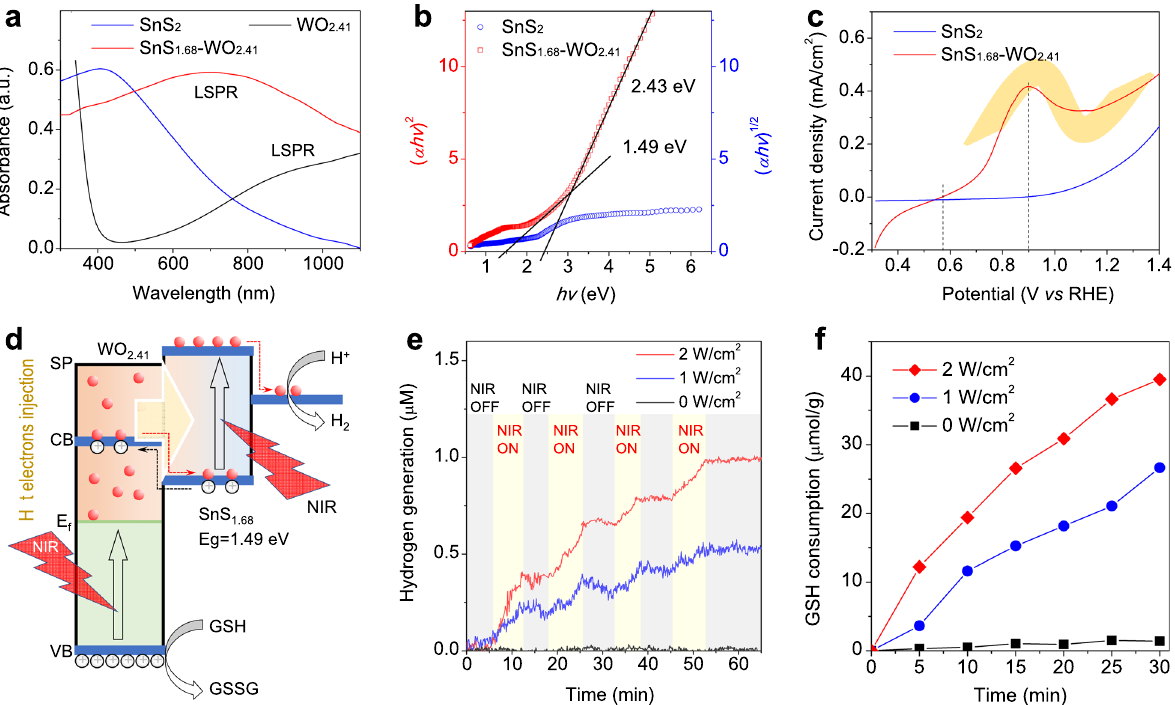
Fig. 3 Photoelectric features and NIR-photocatalytic hydrogen generation and GSH consumption performances of the SnS 1.68 – WO 2.41 nanocatalyst. UV – VIS – NIR adsorption spectra ( a ), the plots of ( α h ν ) 1/2 and ( α h ν ) 2 versus energy ( hv ) for band gaps of SnS 2 and SnS 1.68 – WO 2.41 ( b ), photocurrent density – voltage (vs. RHE) curves of SnS 2 and SnS 1.68 -WO 2.41 under irradiation of 808 nm laser ( c ), the schematic illustration of the mechanism for NIR- photocatalytic hydrogen generation and GSH consumption ( d ), NIR-photocatalytic hydrogen generation behavior of the SnS 1.68 – WO 2.41 nanocatalyst in the aqueous solution of GSH (10 μ M) under irradiation of 808 nm laser at various power densities ( e ), NIR-photocatalytic GSH consumption behavior of the SnS 1.68 – WO 2.41 nanocatalyst under irradiation of 808 nm laser at various power densities ( f ). The experiments for fi gures a , e , f was repeated three